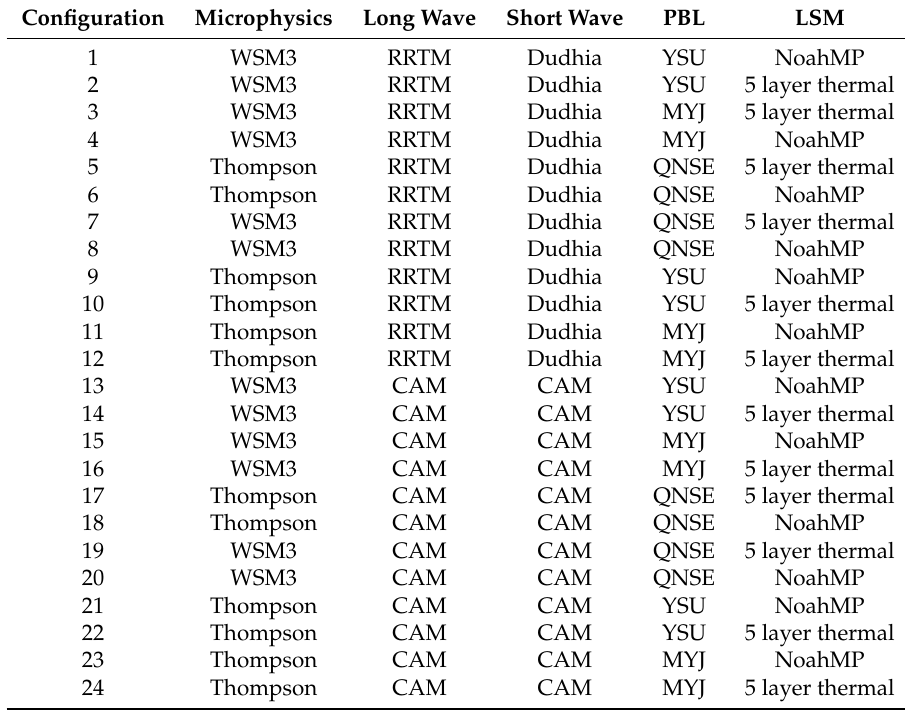
Table 3. WRF Physics